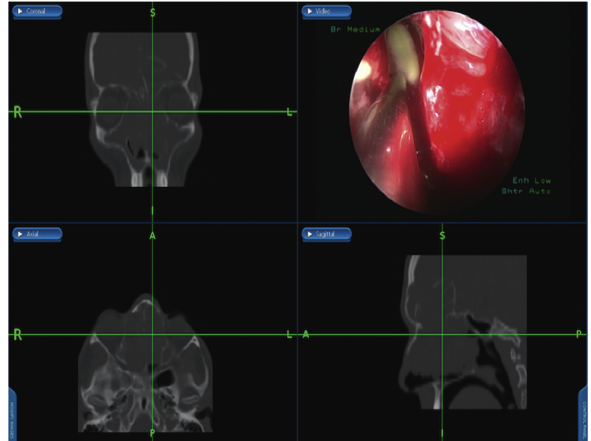
Figure 6: Identification of obstructing infected polyps in the frontal recess that were removed and drained by image-guided endoscopic sinus